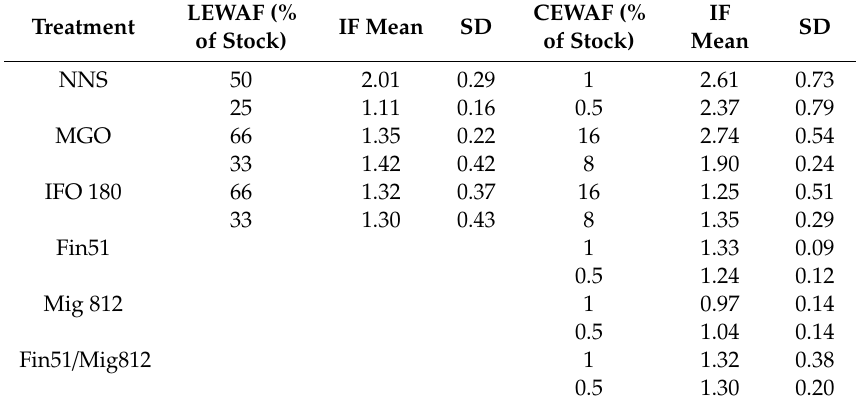
Table 3. Calculated induction factors (IFs) of micronuclei formation in ZF-L cells exposed to WAF dilutions of crude oil (NNS) and refined petroleum products (MGO, IFO 180) as well as dispersant combinations (HEWAF). Mean IFs and standard deviations (SDs) were calculated as